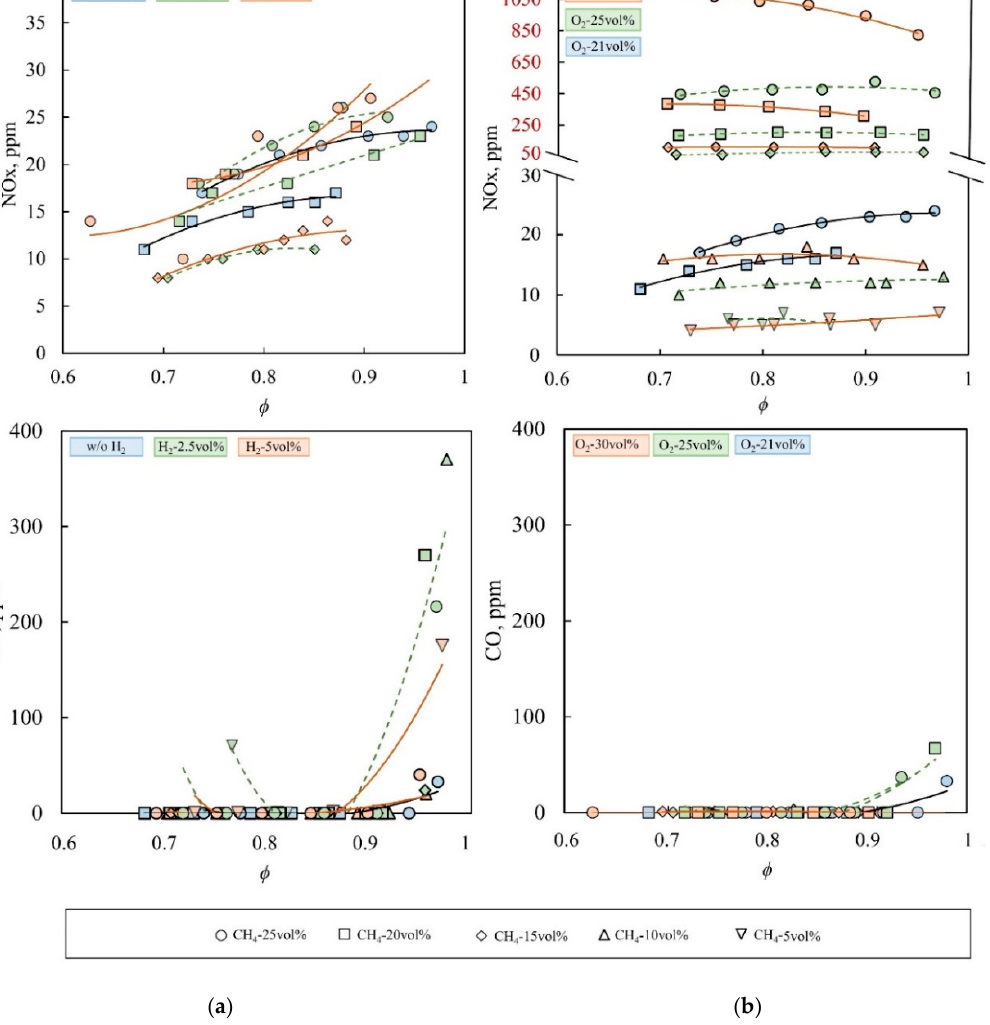
Figure 8. NOx and CO emissions of all tested waste biogas (LCV) mixture combustion under hydrogen-enrichment ( a ) and oxygen-enriched air ( b ) versus fuel-to-air ratio.